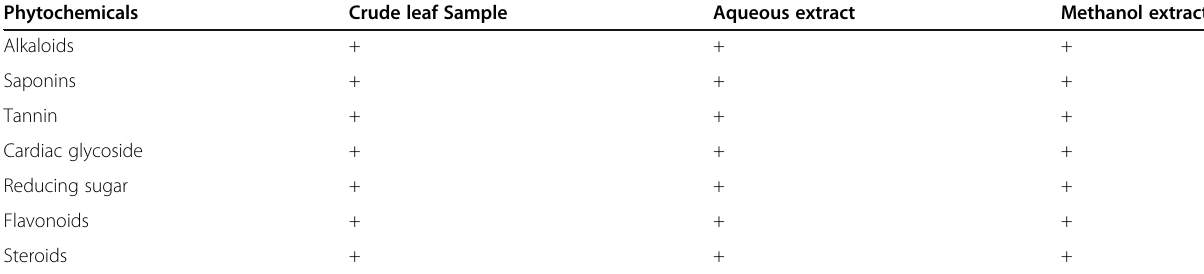
Table 2 Qualitative analysis of secondary metabolites of Dennettia tripetala leaves extracts